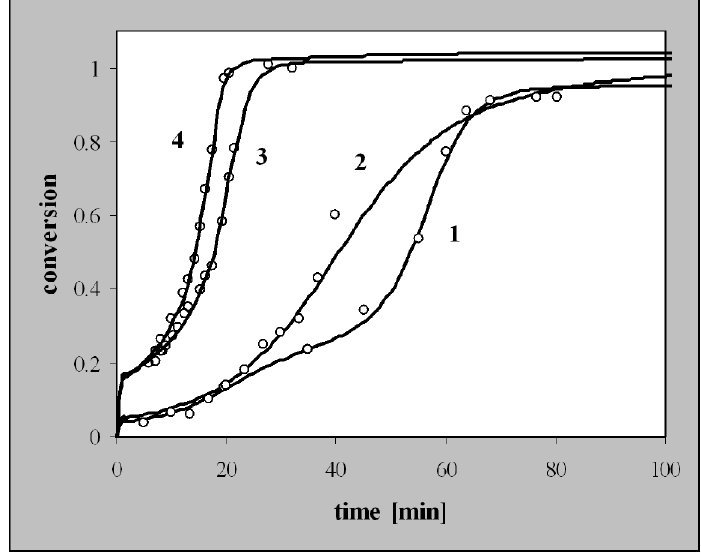
Fig. 4 Variation of monomer conversion with time for the following conditions: (1) T = 70 o C and I 0 = 25.8 mol/m 3 ; (2) T = 70 o C and I 0 = 100 mol/m 3 ; (3) T = 90 o C and I 0 = 15.48 mol/m 3 ; (4) T = 90 o C and I 0 = 25.8 mol/m 3 ; o { experimental data [15,16]; solid lines { predictions of MLP (3:9:3:1) on training data